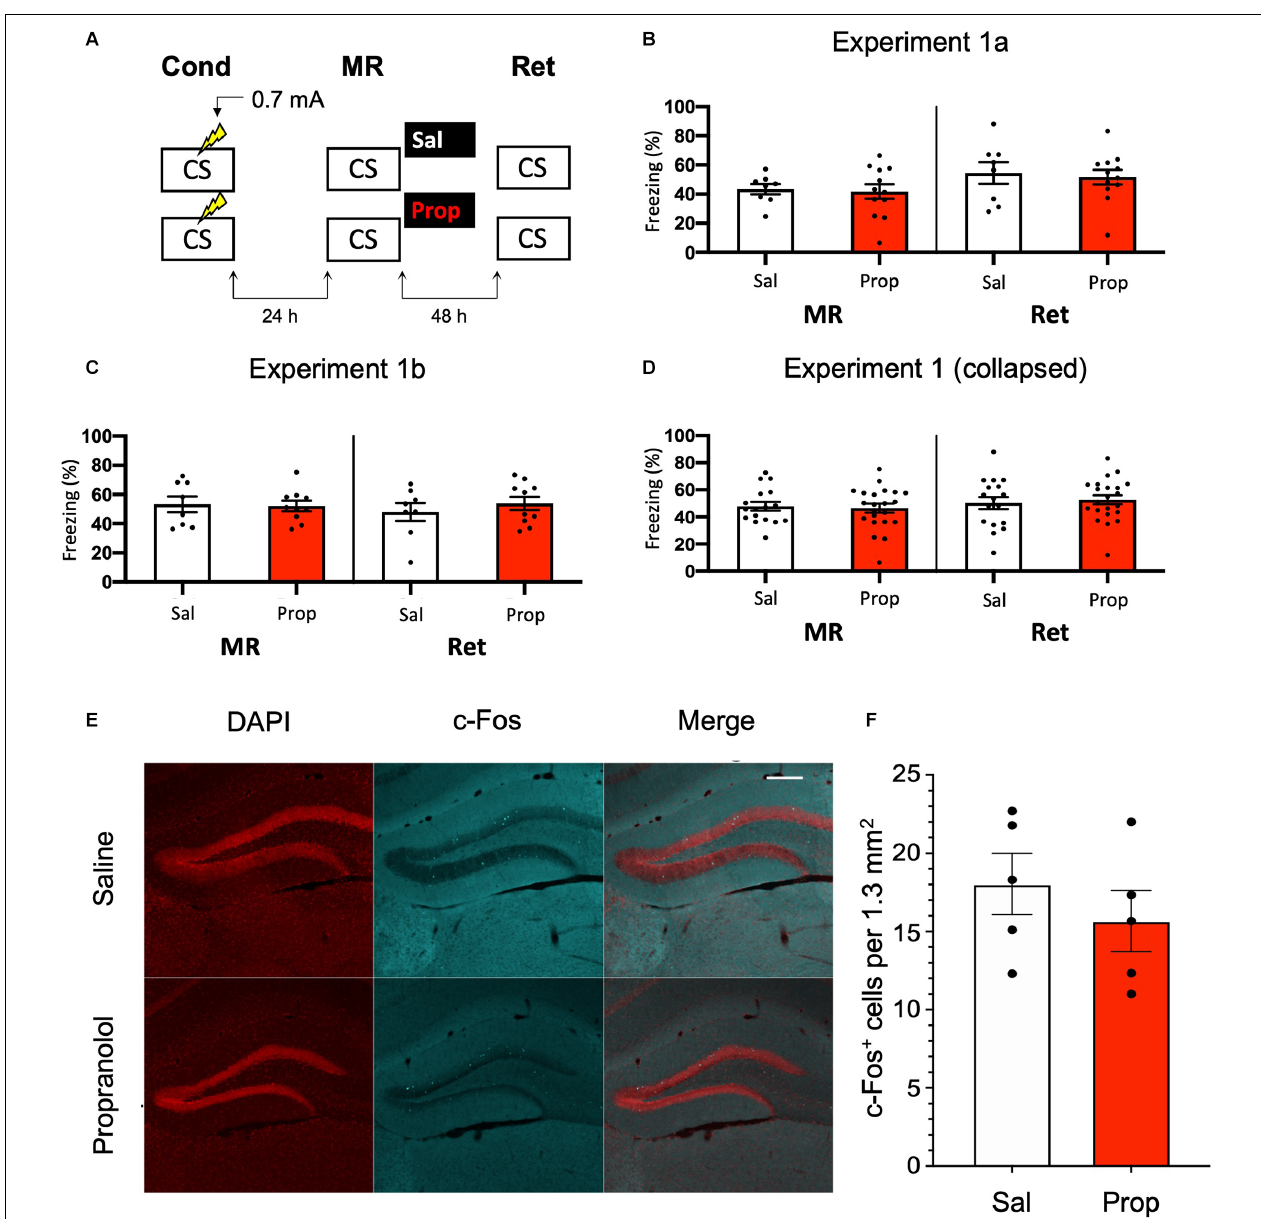
FIGURE 1 | No effect of propranolol on reactivated memories that were acquired with a single 0.7 mA shock during contextual fear conditioning. (A) Design of Experiment 1. Mice received one 0.7 mA shock during fear conditioning. One day later, saline ( n = 8) or propranolol ( n = 12) was administered after memory reactivation. Forty-eight hours afterwards, retention of contextual fear was assessed. Cond, conditioning; MR, memory reactivation; Ret, retention; CS, conditioned stimulus (context); Sal, saline; Prop, propranolol. (B) Results of Experiment 1a. Average percentage of freezing during memory reactivation is displayed on the left, and freezing during the retention test on the right panel of the column chart (saline in white bars, propranolol in red bars). Error bars represent SEM. Filled circles indicate individual animals. (C) Results of Experiment 1b (saline, n = 9; propranolol, n = 10). Experiment 1b was a direct replication of Experiment 1a. (D) Collapsed results of Experiment 1a and Experiment 1b. (E) Representative images of the DG 90 min after the retention test from mice that received either saline ( n = 5), or propranolol ( n = 5) after reactivation (Experiment 1a). Cells that were c-Fos + are labeled in cyan (scale bar: 200 µ m). (F) Number of c-Fos + cells in the DG per 1.3 mm 2 . Error bars represent SEM. Filled circles indicate individual